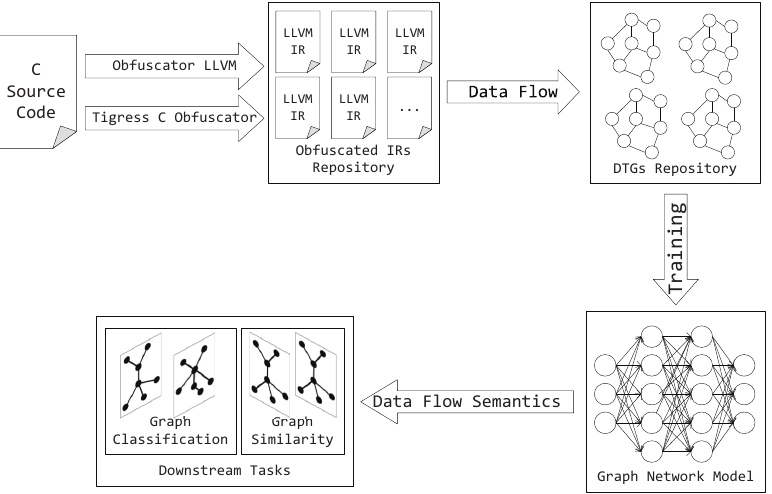
Figure 1. The overall framework of our